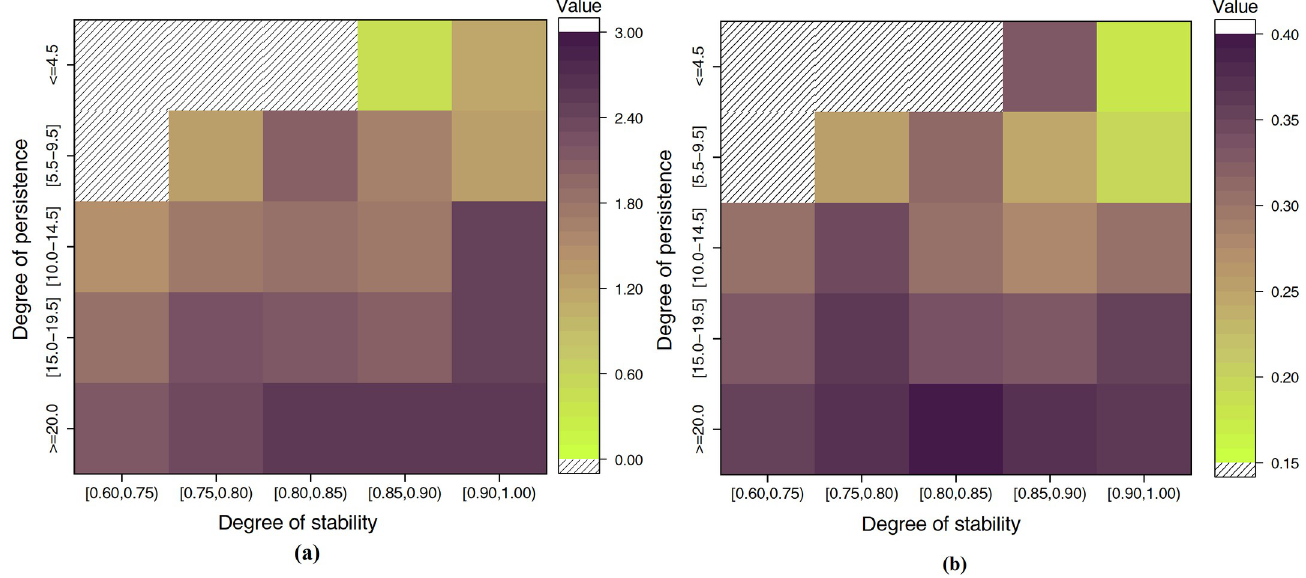
Fig 8. Relationships among collaboration persistence, stability and research performance from different aspects in 1993–2013. (a) the yearly average number of citations (YANC) received and (b) the proportion of coauthored articles that have received at least 10 citations (CAP10C); shading is proportional to the value of the research performance indicators of the collaborative country pairs with the corresponding degree of stability and